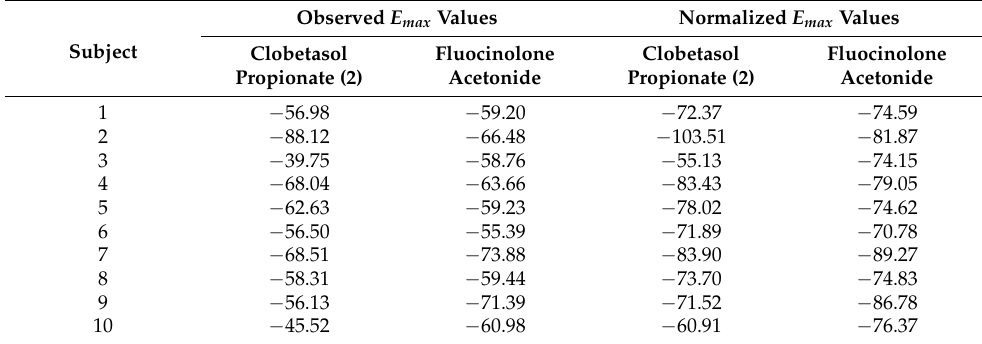
Table 3. Individual subject results from Study 2.